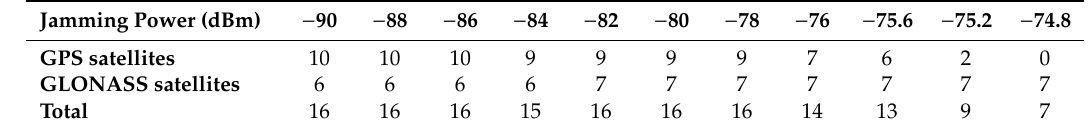
Figure 8. Constellation availability of narrowband interference scenarios. ( a ) Scenario #2; ( b ) Scenario #3. Table 5. Minimum number of available satellites for scenario #2.